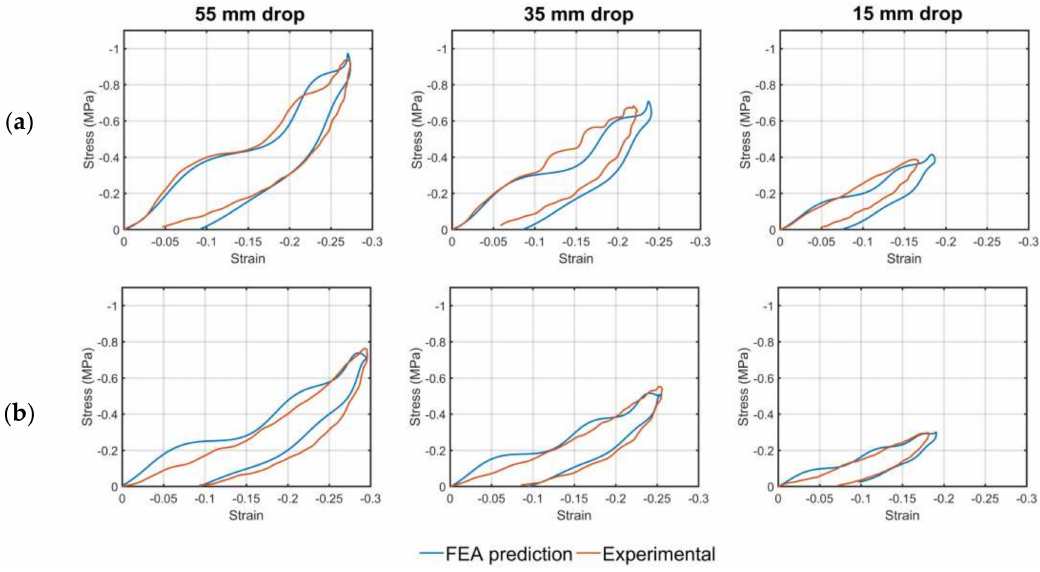
Figure 8. Comparison of stress-strain experimental data against FE simulation outputs across the three drop heights for ( a ) Berleburger and ( b ) Holywell